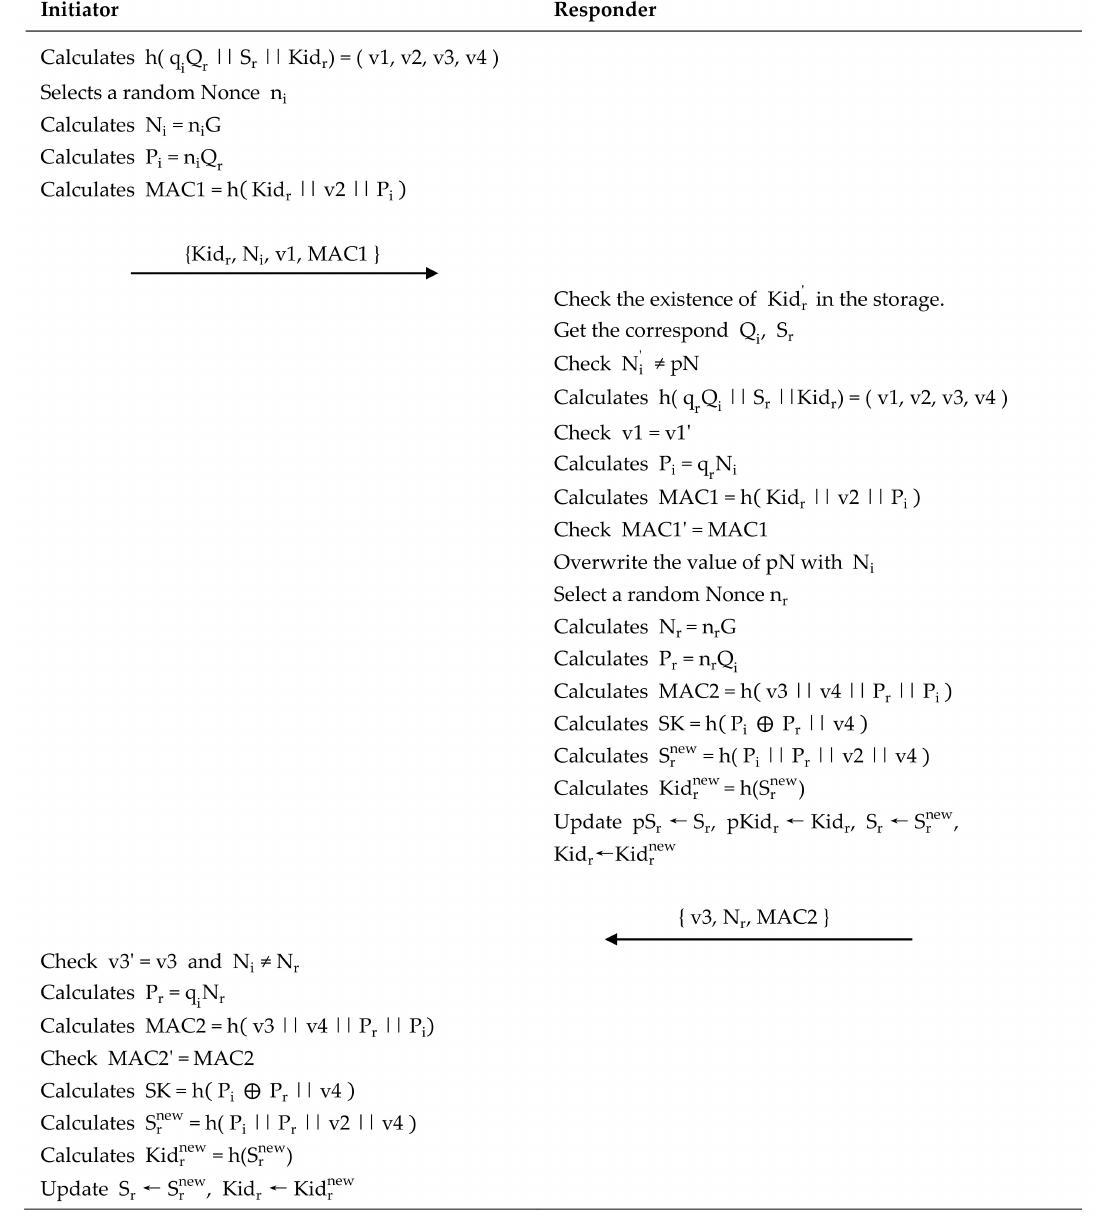
Figure 3. Identity authentication and key agreement